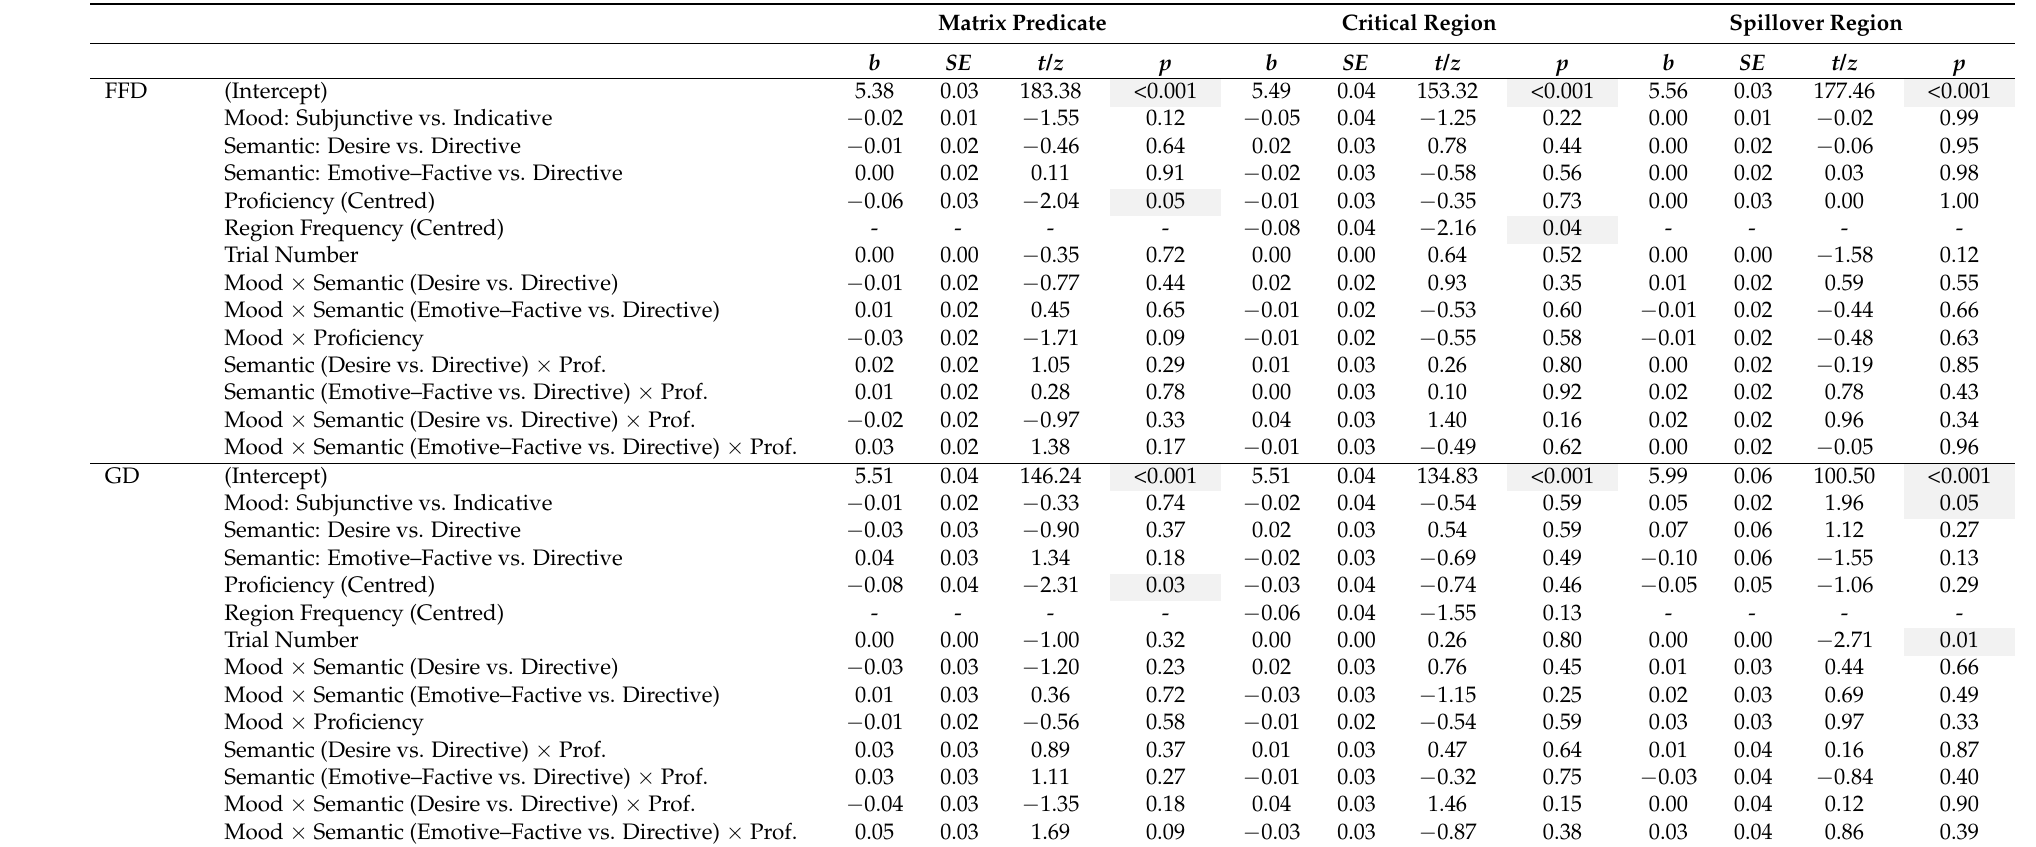
Table A6. Estimates from mixed-effects models for L2 eye movement